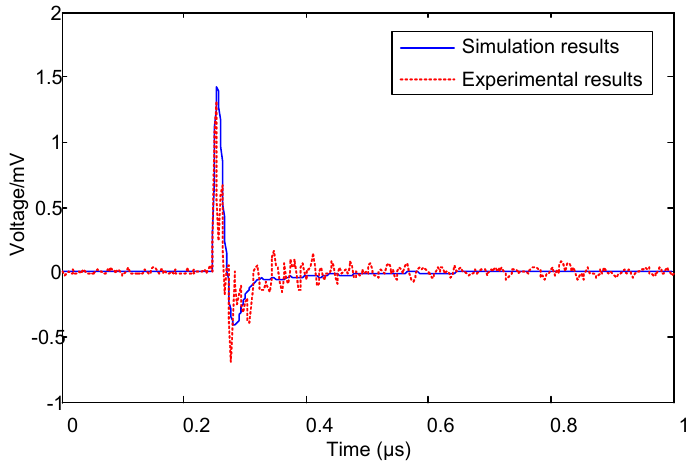
Figure 14. Comparison of the PD current between the simulation and experiment as a response to 1.2 PDIV with 5 mm needle-sphere electrode configuration.